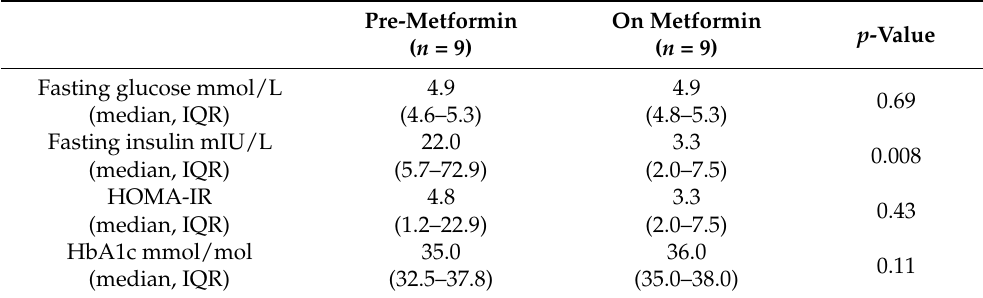
Figure 1. Fasting insulin levels were lower in patients taking metformin compared with their pre-treatment level. Blood samples from HS patients taking metformin pre-treatment and on treatment ( n = 9) were analysed for HOMA-IR and fasting insulin. Graphs represent matched samples. Statistical significance was calculated using the Wilcoxon test. ** p ≤ 0.01. HOMA-IR = homeostatic model assessment for insulin resistance; Met = metformin.